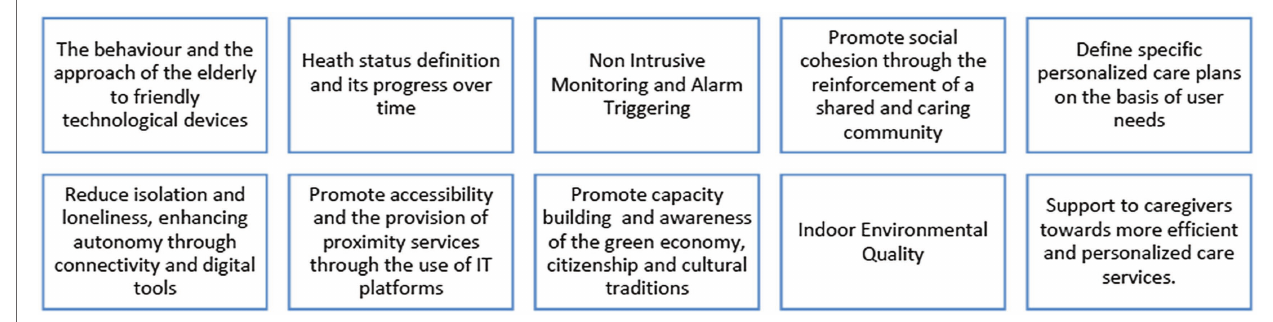
FIGURE 1 | Challenges addressed by the Pharaon project.